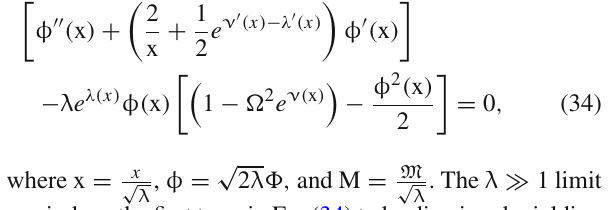
√ 2 λ M pl Fig. 3 Dark SU( N ) MGD star ratio M ( x R ) , normalized by , m 2 x 3 R ν ( 0 ) σ → with respect to e (cid:9) 2 . The dashed black line regards the GR limit ∞ ; the other lines depict the phenomenological bound for the brane tension σ (cid:2) 3 . 18 × 10 − 6 GeV 4 . The standard MGD procedure is a particular case of the EMGD for k = 0 (black line); the EMGD case is plot for k = 1 (gray line) and for k = 2 (gray dashed line) Table 1 Peak values of the dark SU( N ) EMGD stars radius √ √ 2 λ 2 λ ( normalized by ) , as func- M pl ) and mass ( normalized by M 3 pl m 2 m 2 tions of the fluid brane tension, for the MGD ( k = 0 and for the EMGD ( k = 1 and k = 2) ν ( 0 ) Brane tension σ e (cid:9)